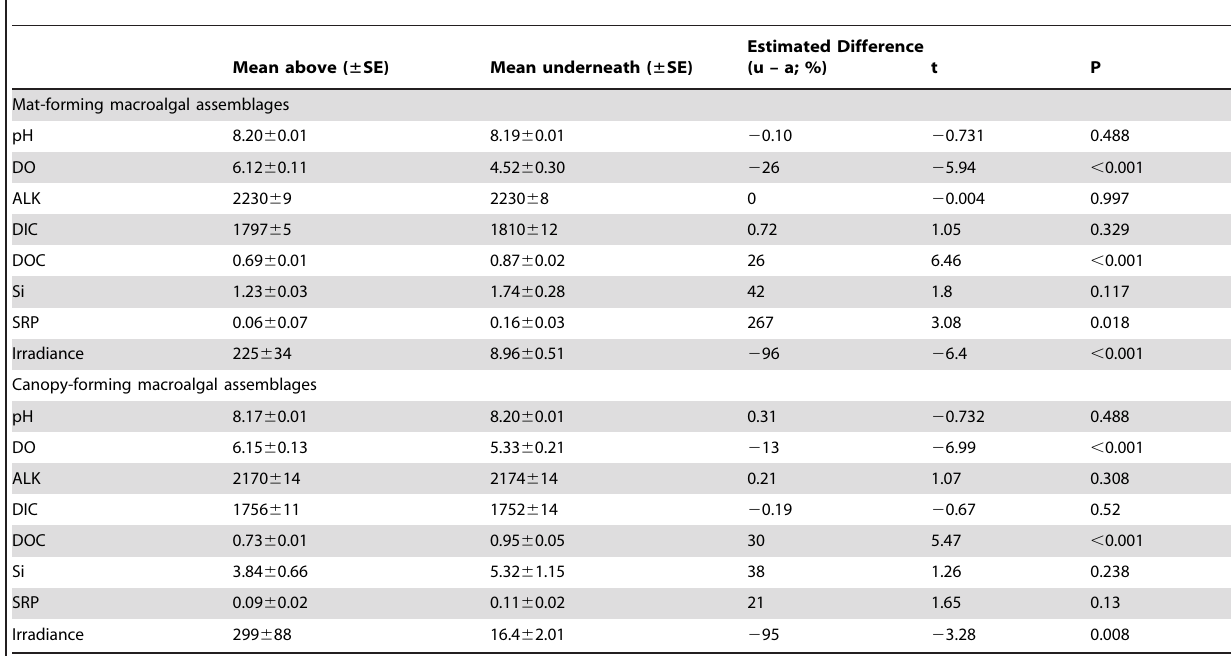
Table 1. Physical and chemical conditions underneath and above macroalgal assemblages in the field on inshore coral reefs.